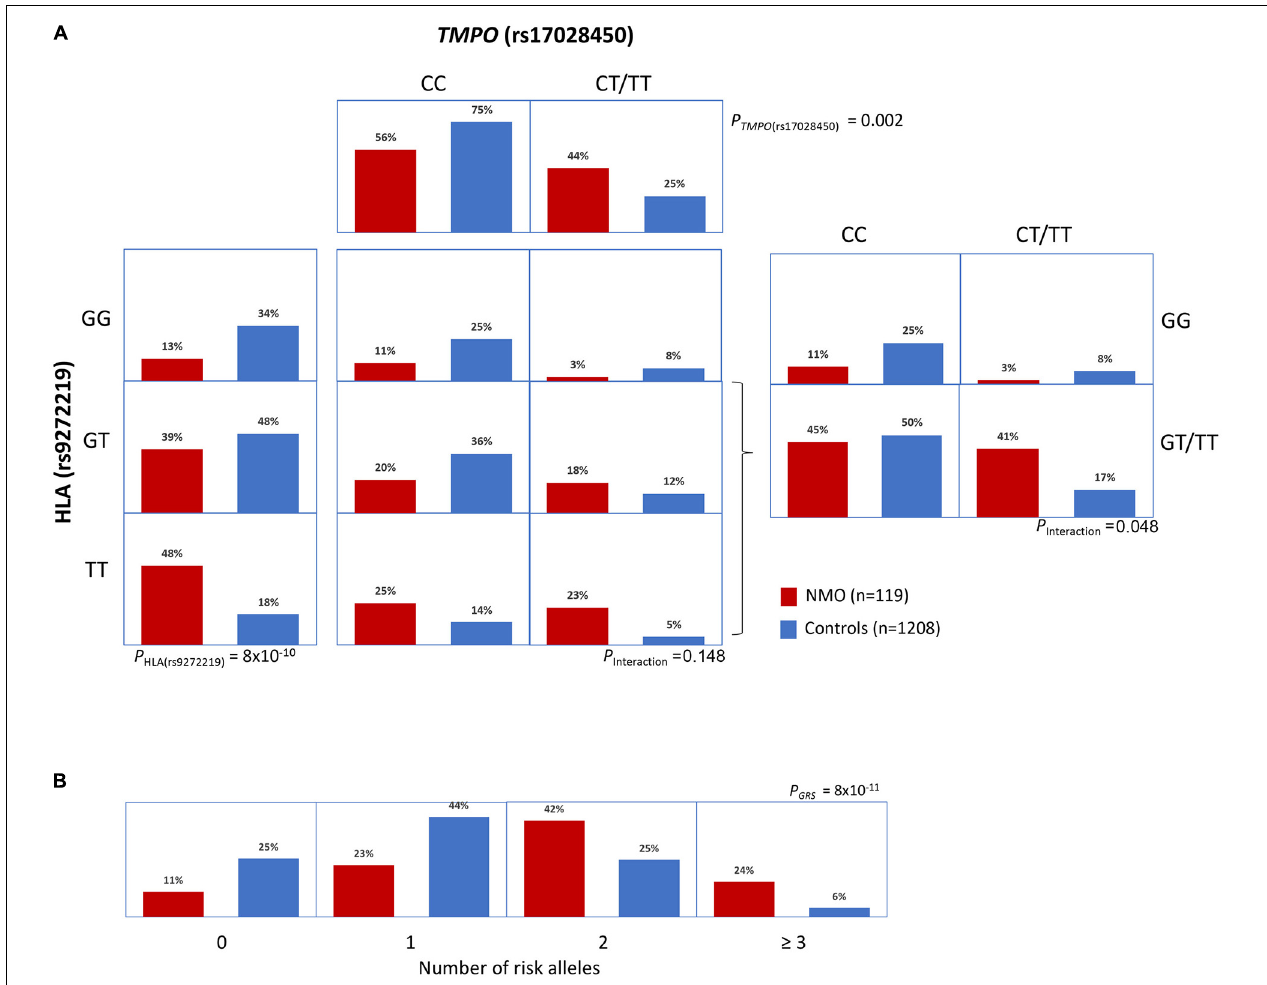
FIGURE 2 | Interaction and genetic risk score analyses. (A) Distribution of NMOSD cases and controls across genotypes for HLA rs9272219 and TMPO rs17028450 genetic variants. The TMPO variant was analyzed assuming a dominant inheritance model mainly because of the reduced number of TMPO “TT” homozygous individuals. (B) Distribution of cumulative risk alleles (HLA rs9272219 and TMPO rs17028450) in cases and controls.